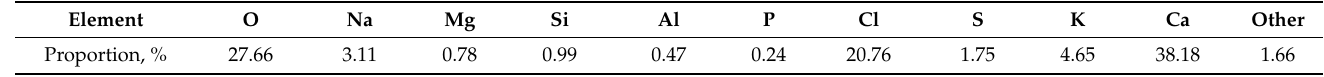
Table 1. Distribution of H-MSWIFA elements.